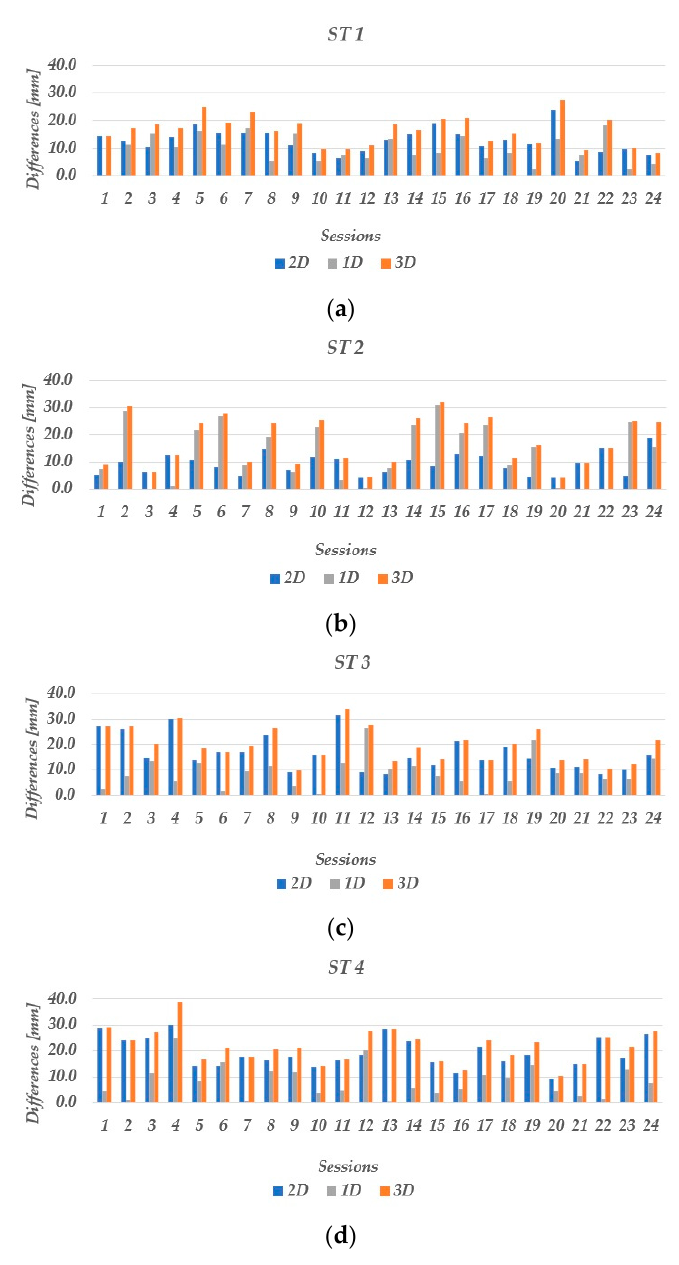
Figure 11. Horizontal, vertical, and spatial positioning accuracy in the open-sky (ST 1) and urban areas (ST 2, ST 3, ST 4): ( a ) LC − 1 at ST 1; ( b ) LC − 1 at ST 2; ( c ) LC − 1 at ST 3; and ( d ) LC − 1 at ST 4.